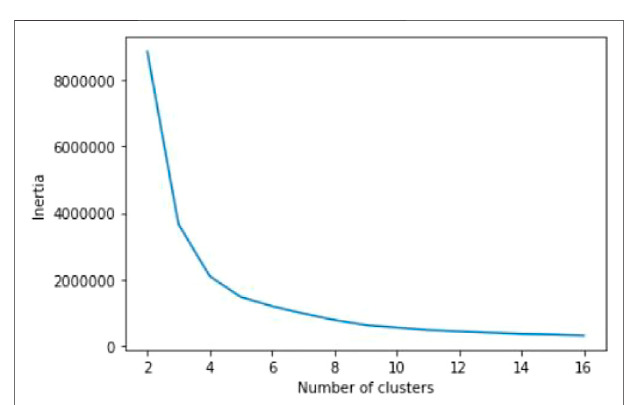
FIGURE 3 | Optimum value of number of